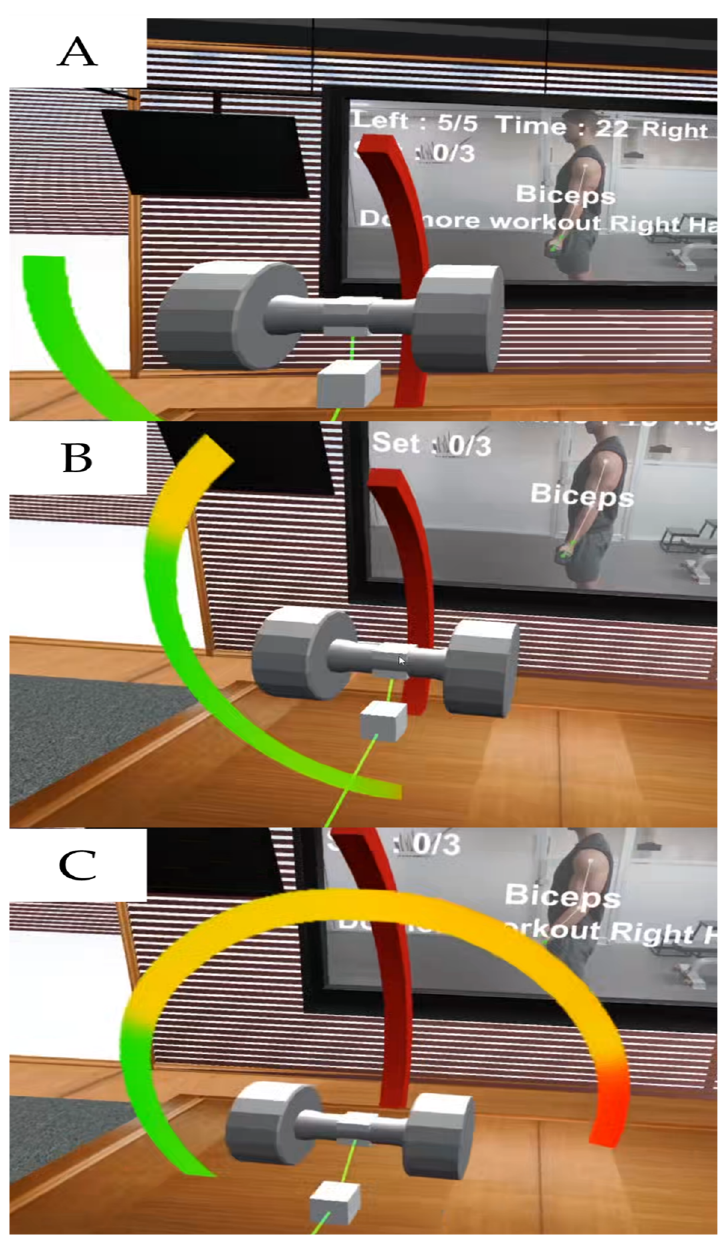
Figure 6. Force representations of FGCGUI: ( A ) lacking lift force, ( B ) proper lift force, and ( C ) excessive lift force.